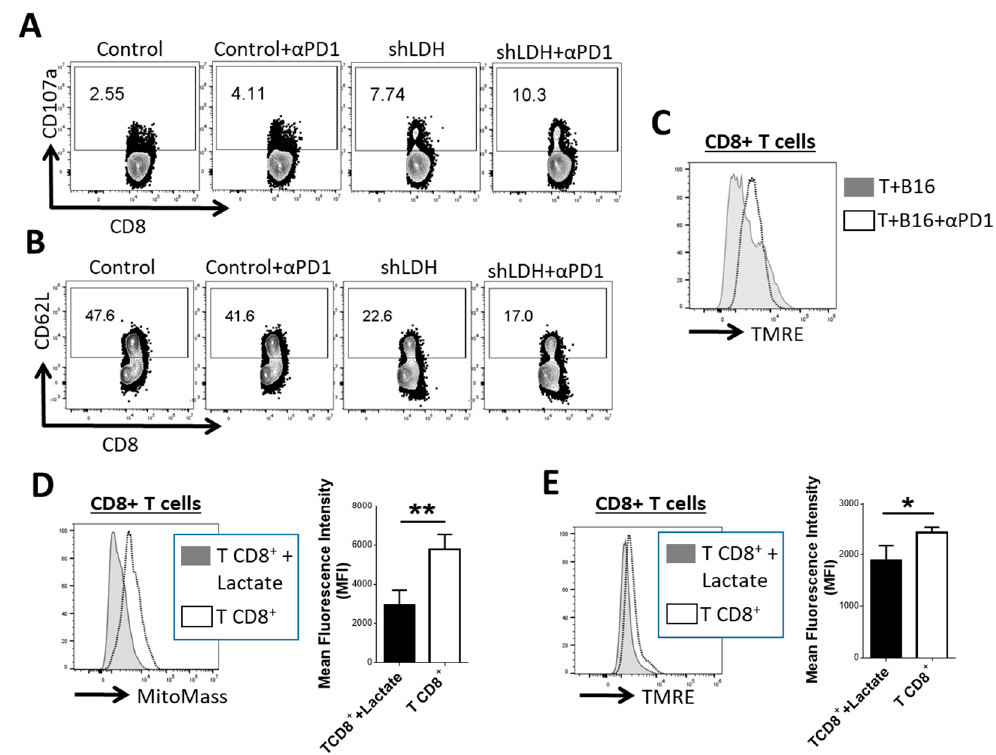
Figure 4. CD8 + T cells co-cultured with LDH-A deletion tumor cells or exposure to lactate in vitro. ( A ) Representative flow cytogram of a degranulation marker (CD107a) on CD8 + T cells, co-cultured for 24 h with LDH-A deleted melanoma cells in vitro. ( B ) Differential expression of CD62L marker on CD8 + T cells after co-culture for 24 h in vitro with LDH-A deleted B16-F10 melanoma cells. ( C ) Effect of added anti-PD-1 on CD8 + T cell’s mitochondrial potential (detected by tetra-methylrhodamine ester (TMRE)) while co-cultured with melanoma cells for 24 h; p < 0.05. ( D – E ) Mitochondrial mass and mitochondrial potential of CD8 + T cells exposed to L -lactate (10 mm) for 24 h. * p < 0.05. ** p < 0.01.